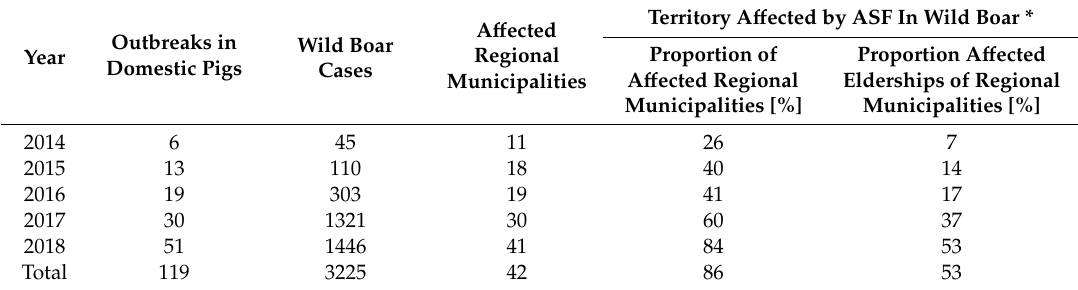
Table 1. African swine fever (ASF) outbreaks in domestic pigs and wild boar cases in Lithuania (2014–2018)